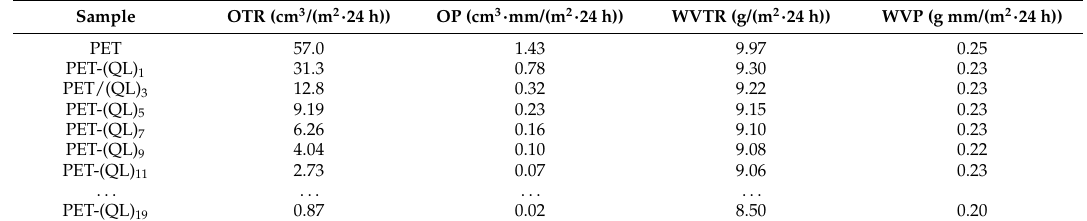
Table 1. Barrier properties of PET and PET/(QL) n /PAA ( n = 0~19). OTR: oxygen transmission rate; OP: oxygen permeability coefficient; WVTR: water vapor transmission rate; WVP: water vapor permeability coefficient.